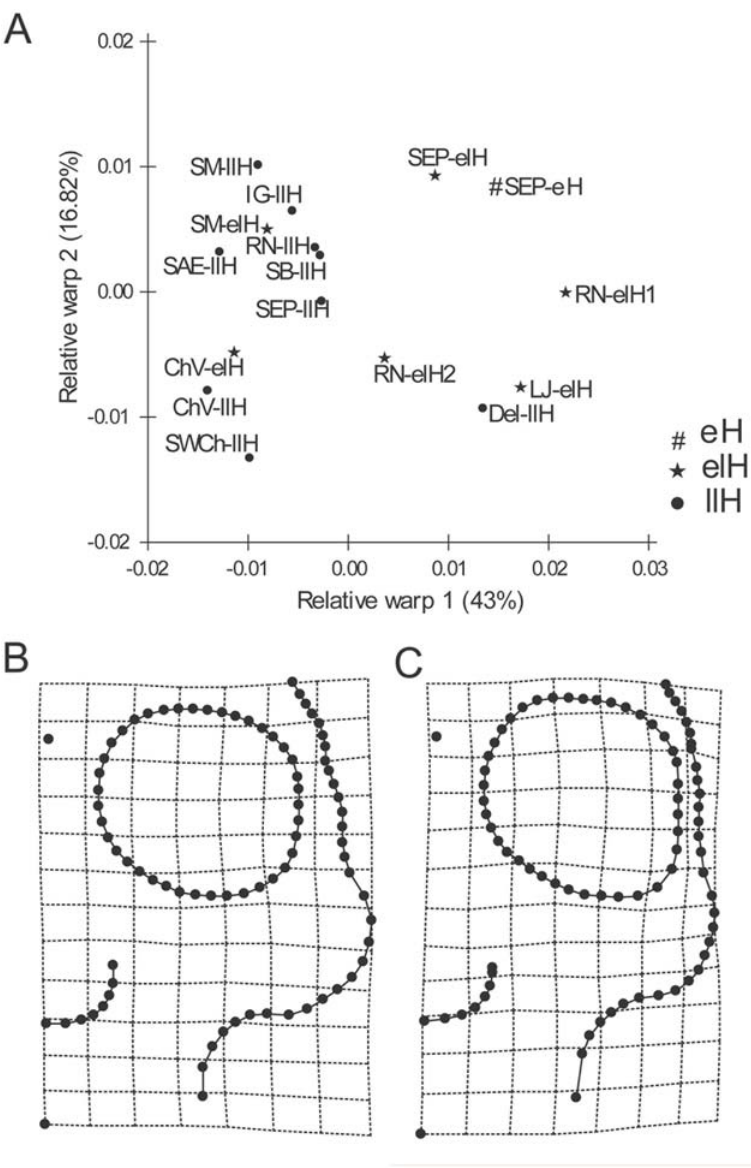
Figure 3. Relative Warp analysis of the face. A) Ordination of the 16 East Central samples in the space of the first two relative warps, based on the partial warp and uniform component variables calculated for the face. The circles ( N ) represent the consensus individual or mean shape for each Later Late Holocene sample (llH), stars ( w ) represent the consensus individual for each Earlier Late Holocene sample (elH), and number sign ( # ) represents the consensus individual for the Early Holocene sample from Arroyo Seco 2 (eH). B and C) Facial shape changes implied by variation along the first relative warp axis is shown as deformation grids. Grids show shape changes for negative (B) and positive (C) deviations from the mean for RW1.